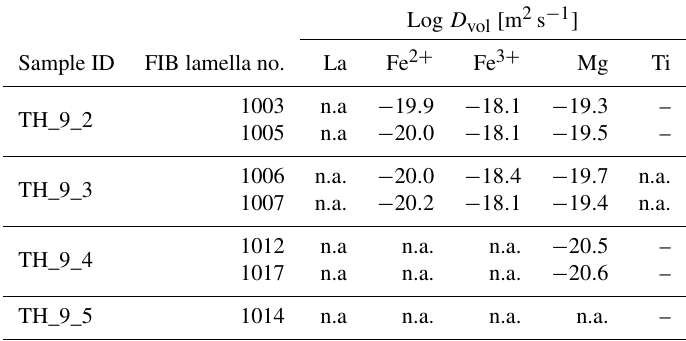
Table 4. Volume diffusion rates of multiple elements in YAG. The abbreviation n.a. means not assigned because the concentration is below the detection